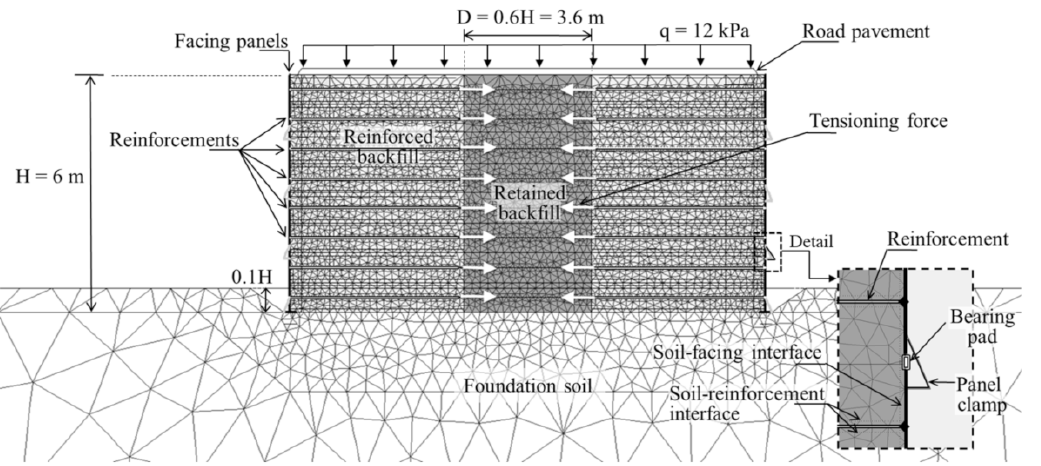
Figure 3. Detail of the FEM model and mesh for the base case with D i = 0.6 H . Note: foundation soil zone has dimensions of 50 m wide and 10 m deep. (Modified from